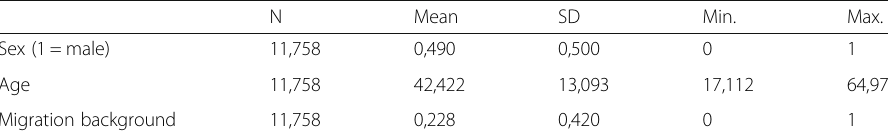
Table 1 Sociodemographic composition